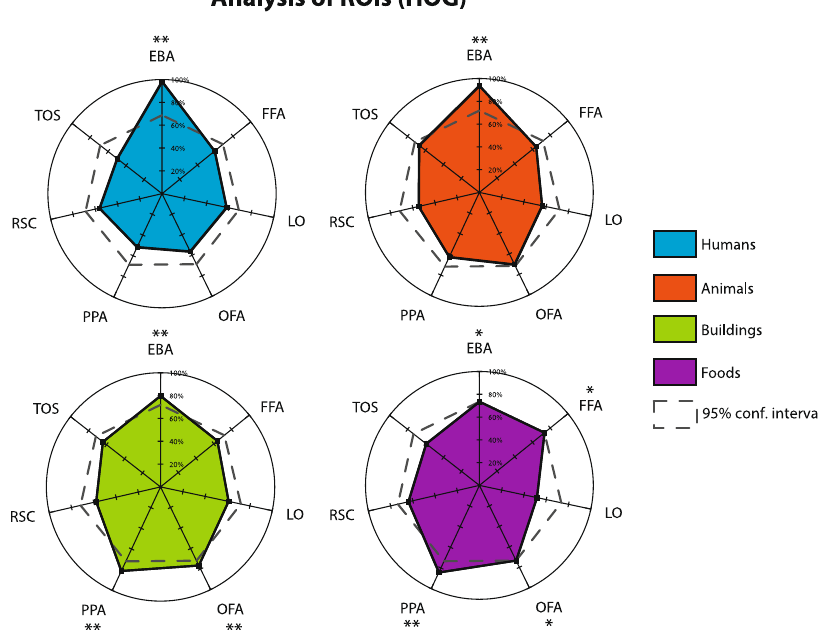
Figure 3. Statistical influence of each ROI in binary object classification models using fMRI activity weighted loss (AWL) and HOG features. In each graph, the percentage of the 64 ROI combinations containing a specific ROI that had a mean classification accuracy greater than that of all 127 sets of experiments is plotted. The threshold for the 95% confidence interval ( p < 0.0004) is overlaid, showing which ROIs significantly differed from the respective null distribution for each object category. Permutation tests and Bonferroni correction ( α = 127) were used. See Figure S3 for a similar plot for CNN features and Figures S4 and S5 for an explanation of how the null distribution was